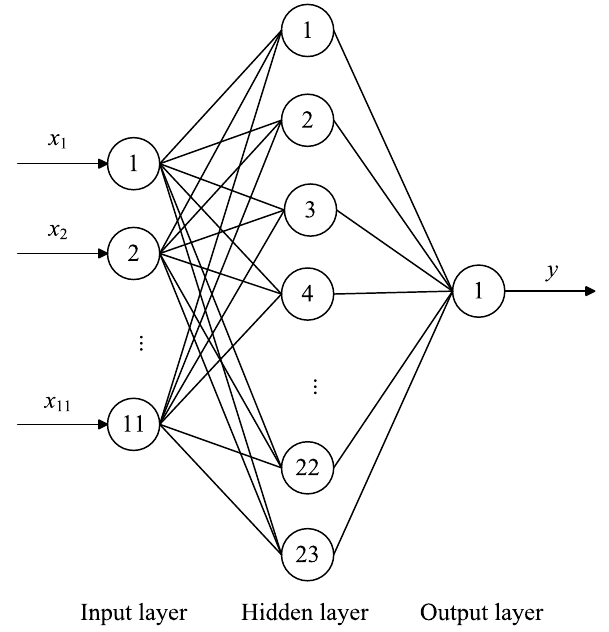
Figure 3. Topological structure of BP neural network